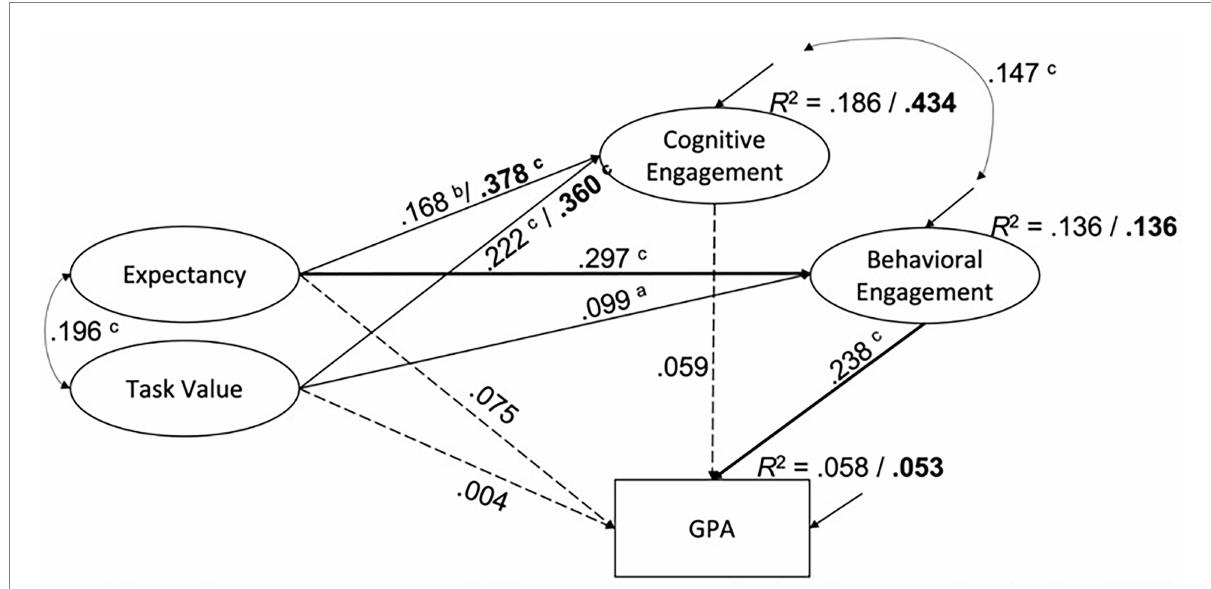
FIGURE 2 Model estimates of the retained multigroup SEM of GPA, expectancy value, and engagement. For paths showing group differences, normal font indicates estimates for CGCS and boldface for FGCS. Bolded paths represent the only significant indirect effect of expectancy on GPA via behavioral engagement, β = 0.071 b . a p < 0.05; b p < 0.01; c p <